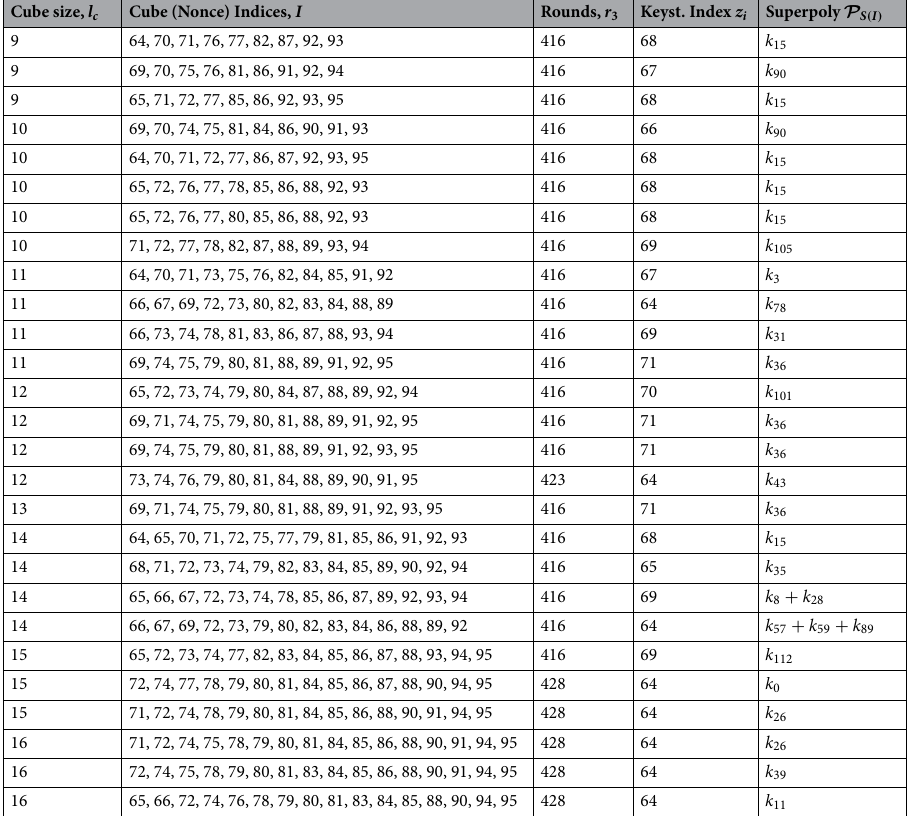
Table 8. A list of superpolies found using KRA2 with reduced cube space V { 64, ··· ,95 }